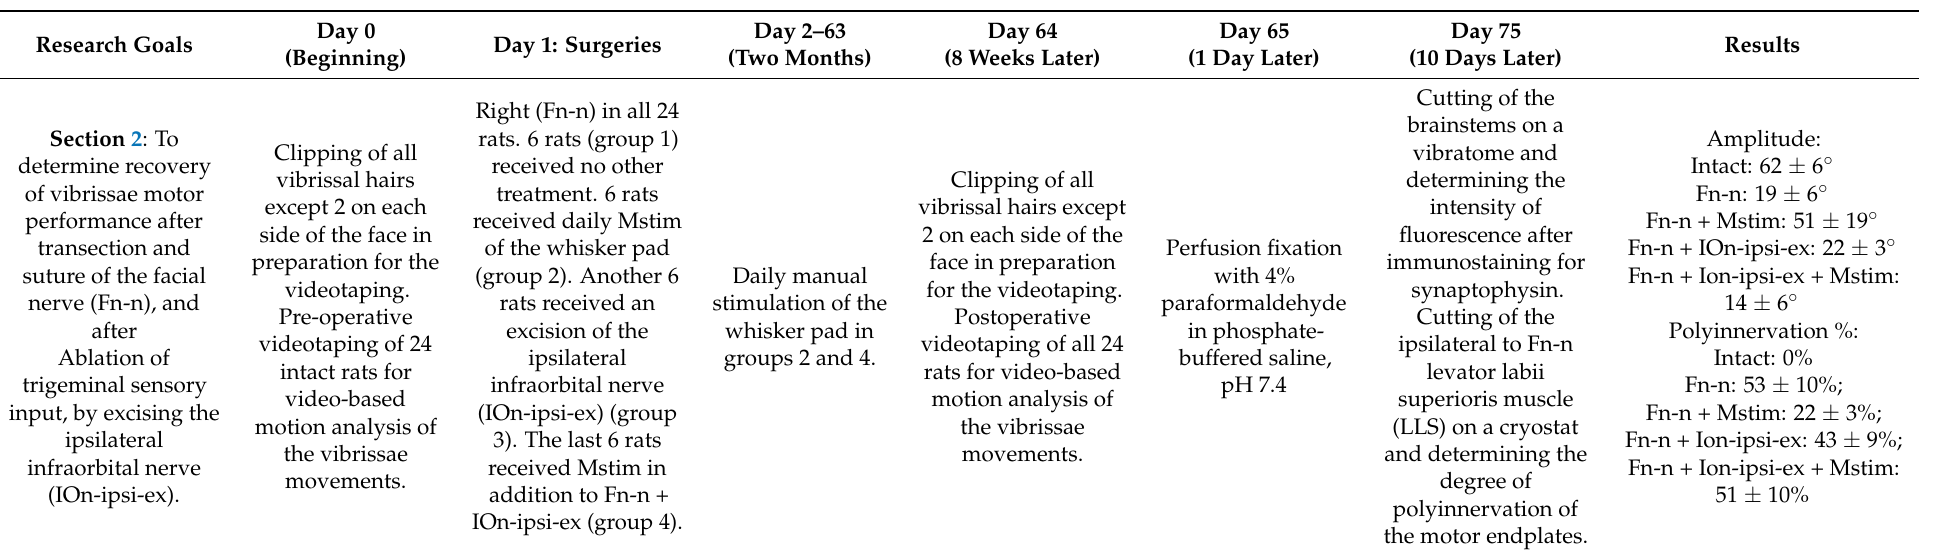
Table 2. Experimental design flow chart depicting animal grouping and sequence of the main procedures in the section, describing the effect of the ablation of trigeminal sensory input on the recovery of vibrissae motor performance after transection and suture of the facial nerve. Fn-n, transection and suture of the facial nerve; Ion-ipsi-ex, excision of the ipsilateral infraorbital nerve; Mstim, manual